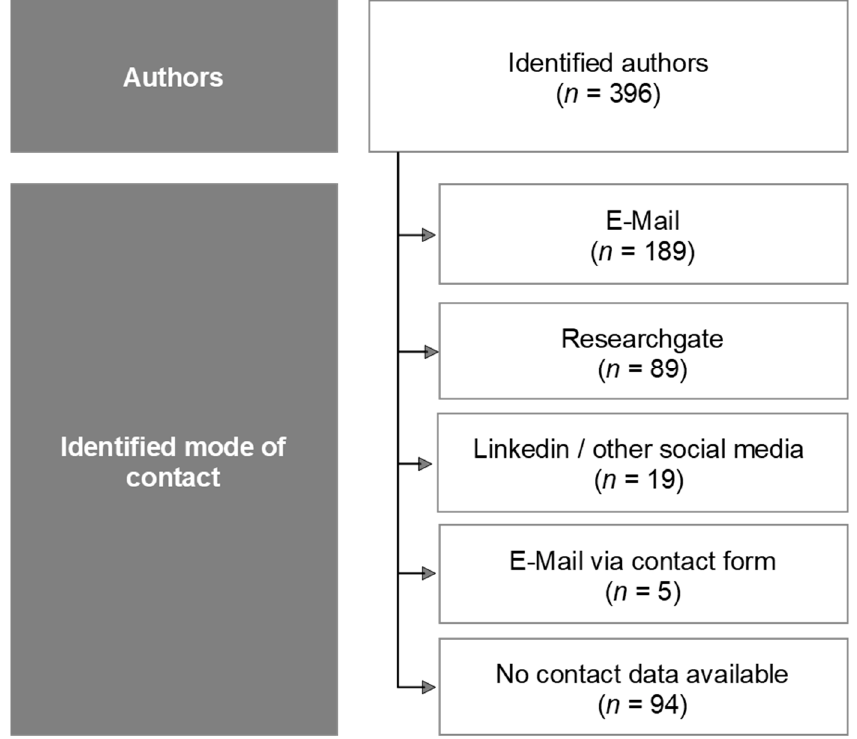
Figure 2. Overview of possible authors/academic experts and contact information.